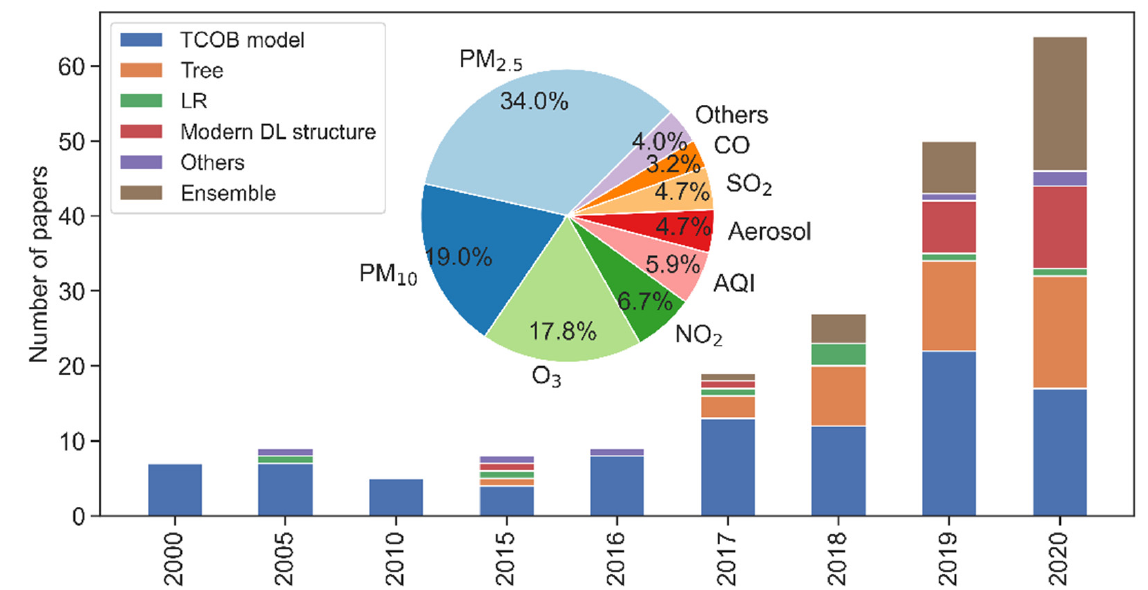
Figure 2. Time series of the number of papers on ML application to atmospheric pollution: bars present the annual number of papers; pie presents species proportion. “Aerosol” refers to aerosol chemical composition classification.